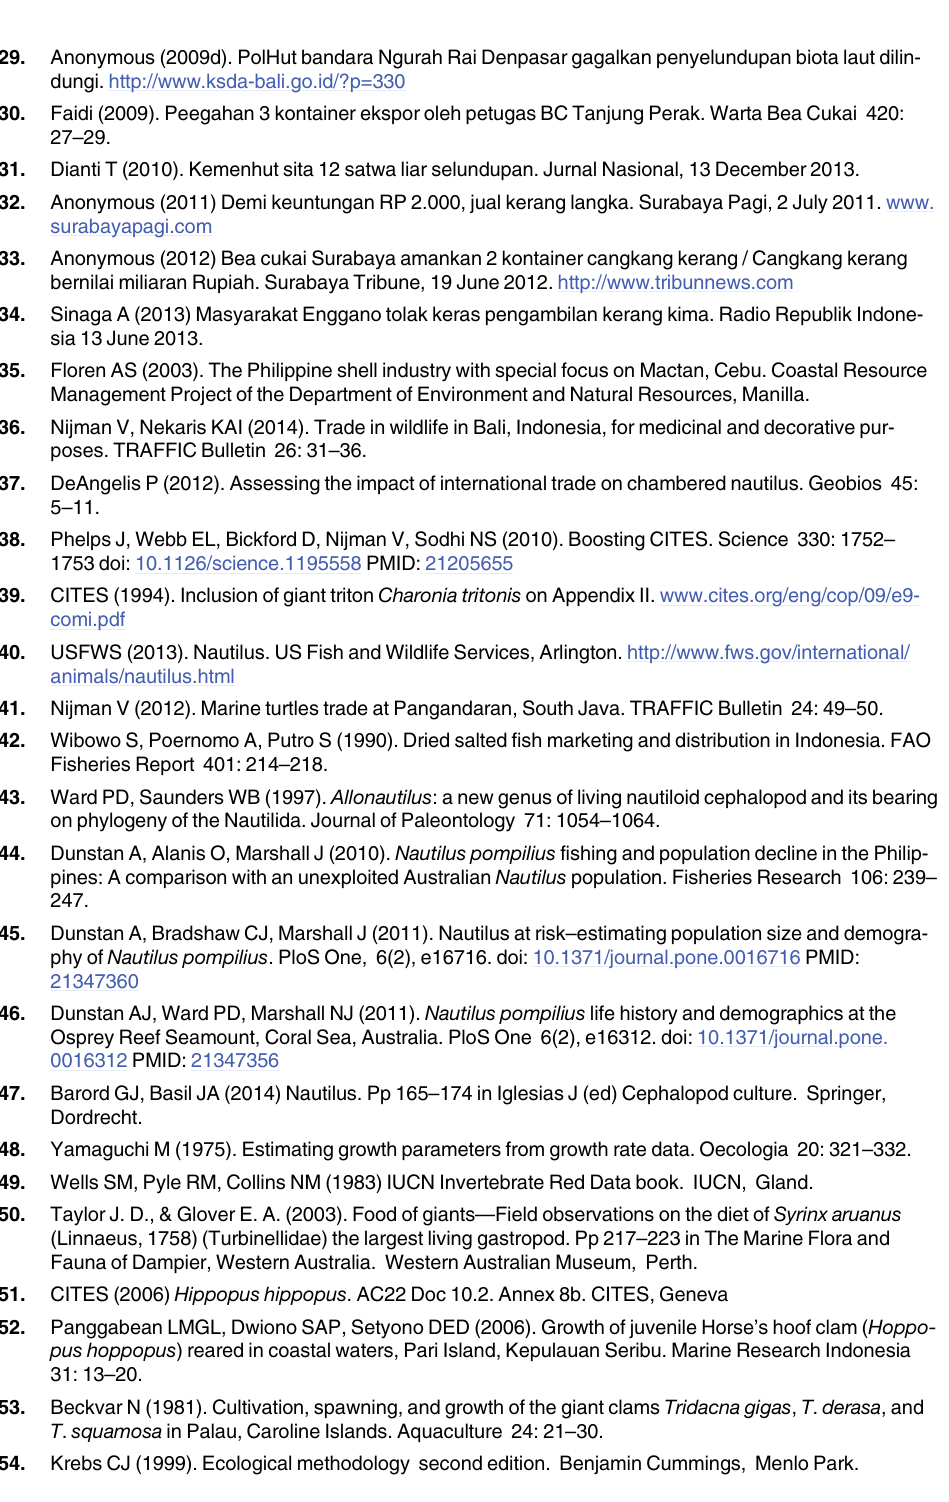
PLOS ONE | DOI:10.1371/journal.pone.0140593 December 30,